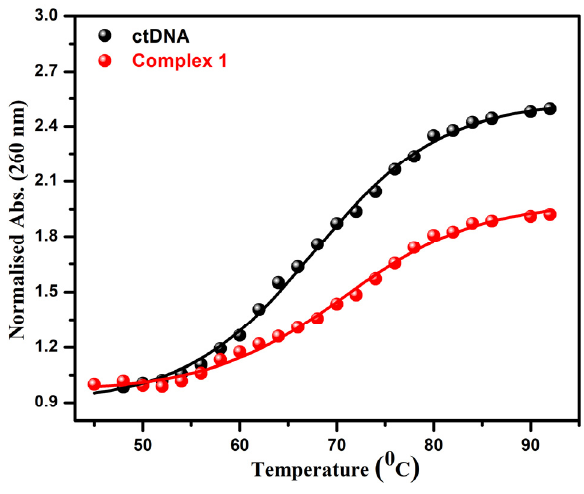
Figure 5. Melting curves of ctDNA ( ● ) and ctDNA + complex 1 ( ● ). [ctDNA] = 70 μ M, [complex] = 10 μ M.